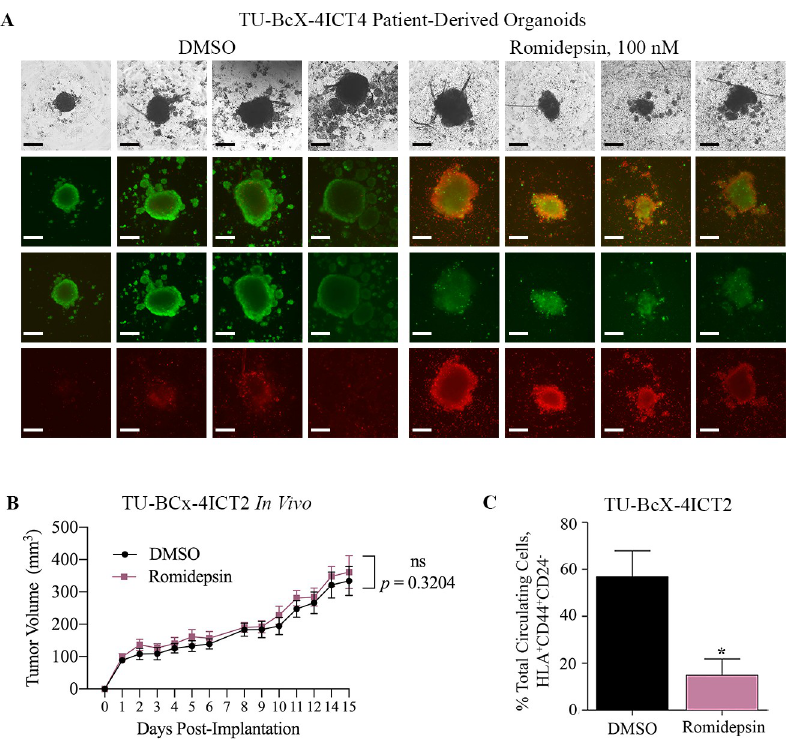
Fig 2. Romidepsin cytotoxicity to TU-BcX-4ICT4 patient-derived organoids and in vivo effects on tumorigenesis and circulating tumor cells. (A) PDX-Os were generated from TU-BcX-4ICT4 in 3D culture conditions and treated for 72 hours with romidepsin (100 nM) or DMSO control. PDX-Os were treated with a live (Calcein AM)/dead (EthD II) immunofluorescent staining kit to highlight live (green) or dead (red) cells. Representative images were captured at 40X magnification (brightfield images) or 50X magnification (immunofluorescent images). Scale bars represent 1.25 mm. (B) TU-BcX-4IC tumor pieces (passage 2; T2) were implanted bilaterally in the mammary fat pads of SCID/Beige mice treated with romidepsin or DMSO vehicle. Tumor volume was measured biweekly with calipers and after 20 days, tumors were excised and mice were sacrificed. (C) Twenty days after tumor excision, peripheral blood was collected to evaluate circulating tumor and stem cell populations, defined as HLA + CD44 + CD24 - . Percentage of circulating tumor cells were significantly reduced in mice treated with romidepsin compared to those treated with DMSO. Error bars represent standard error of mean. � p <